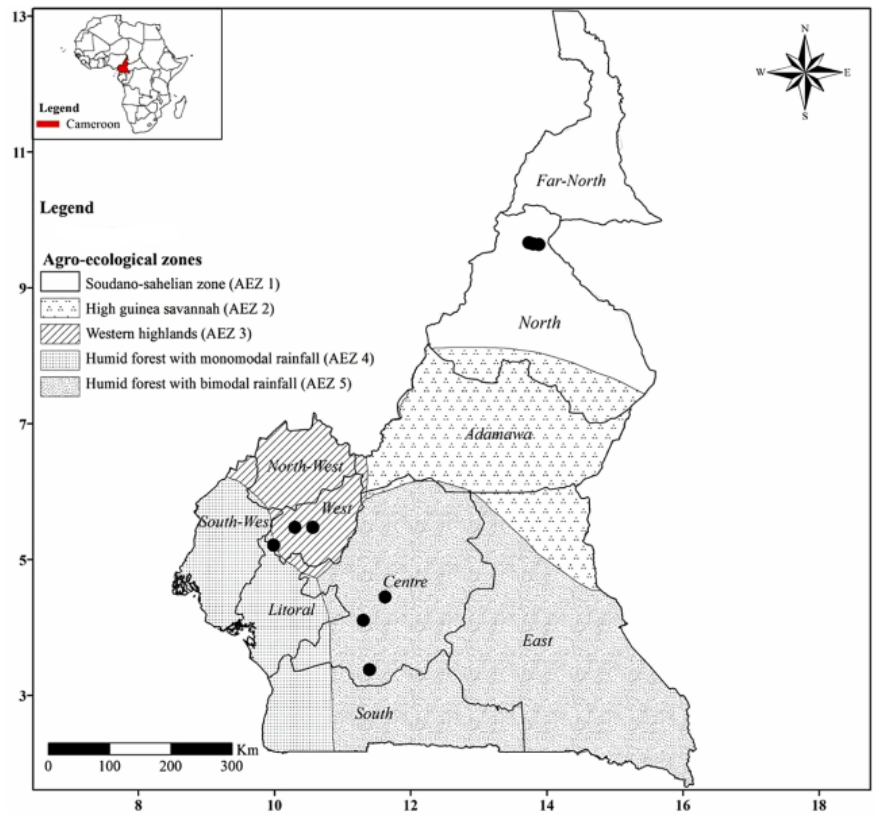
Figure 1. Presentation of agroecological zones of Cameroon. Table 1. Major crops cultivated and animal species reared in each agroecological zone.